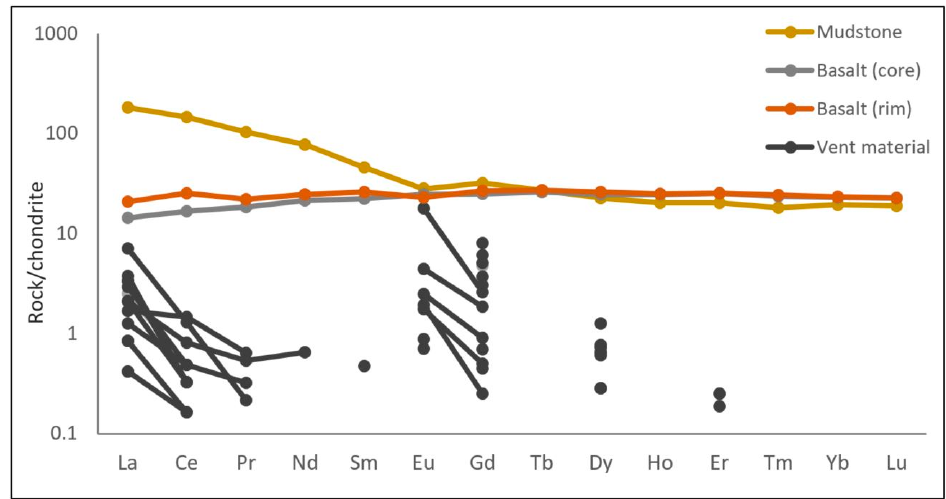
Figure 9. Rare earth element (REE) composition of basalt, mudstone, and sulphide-bearing grab samples from the Loki’s Castle mound flanks (chondrite normalised after [44]).